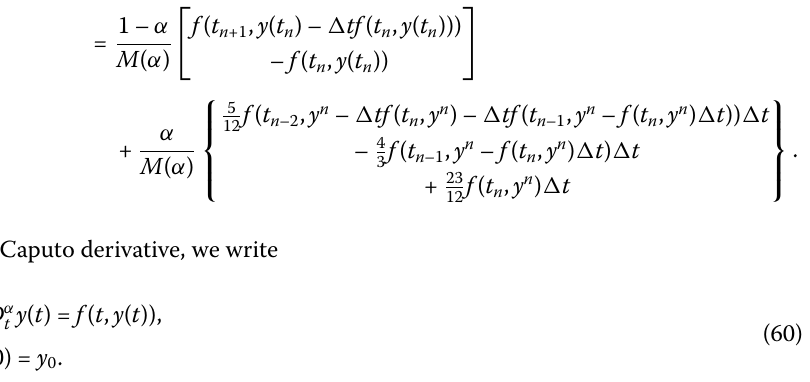
Figure 24 Stochastic behavior of I R ( t ) and I T ( t )